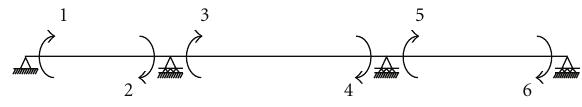
Figure 3: Reference coordinates of the